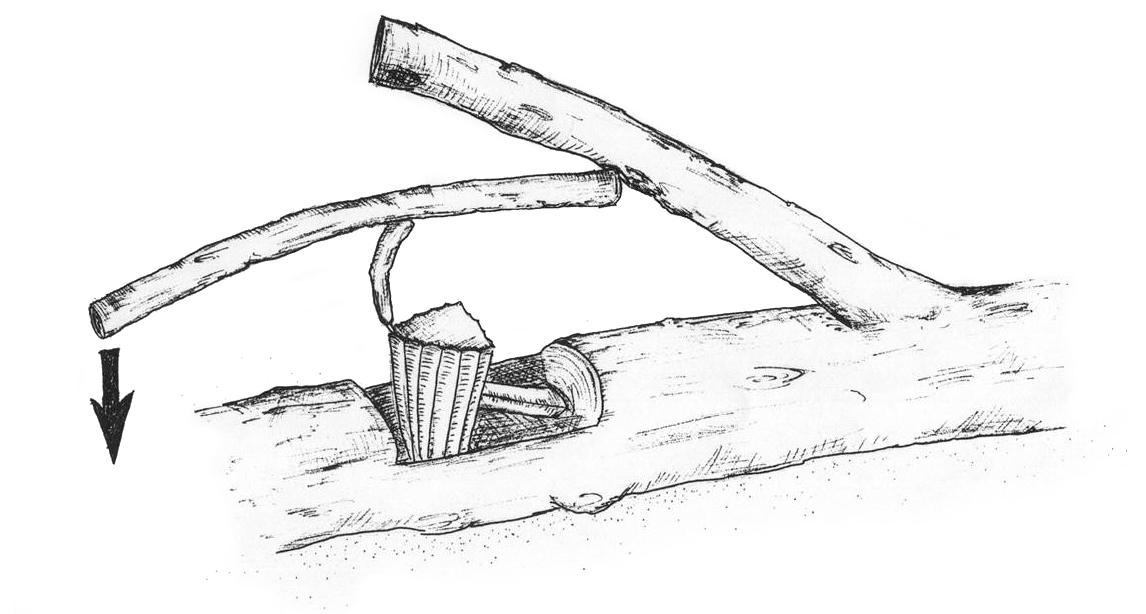
Figure 4. Système expérimental de débitage par pression au levier. Figure 4. Experimental system of pressure knapping with a